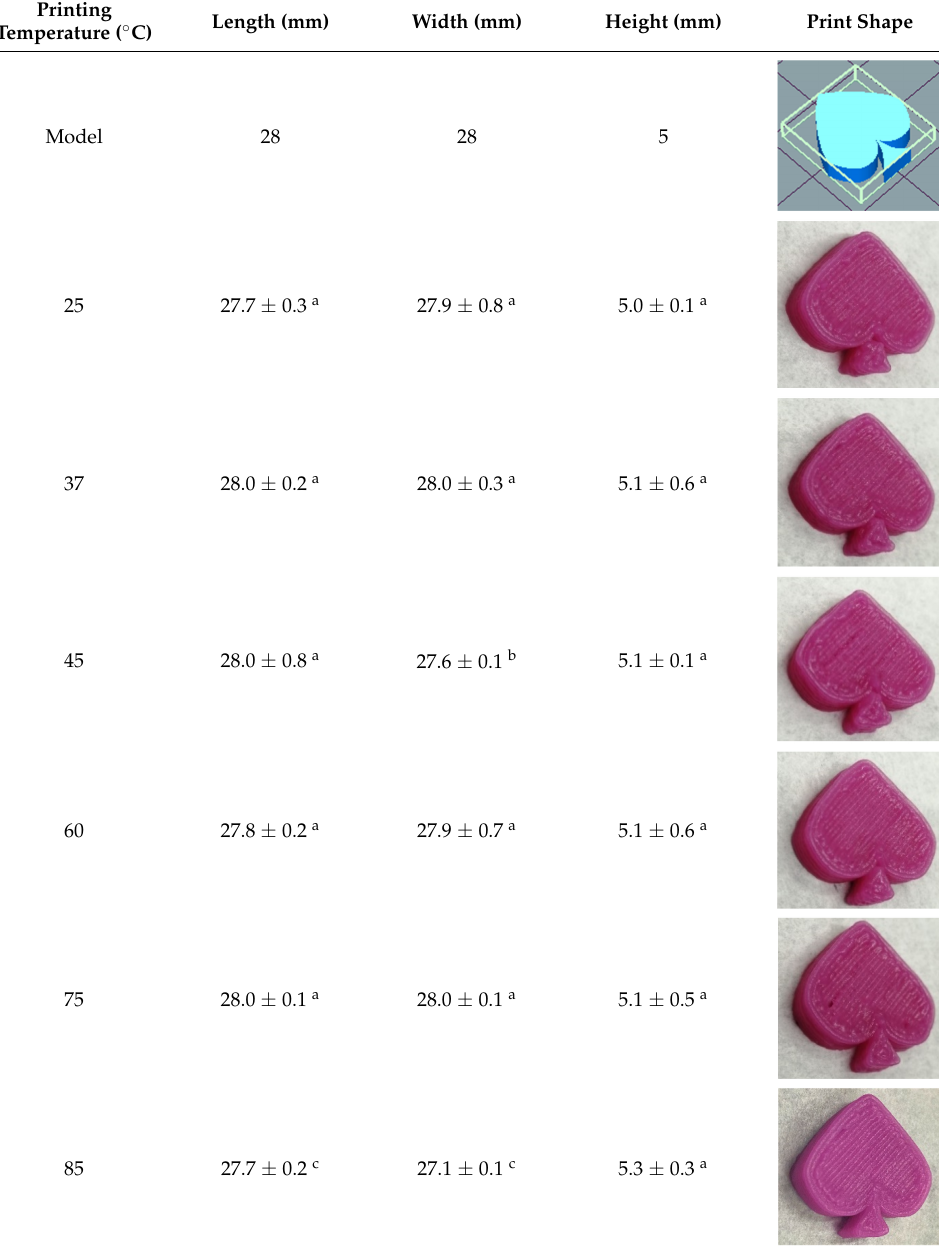
Table 4. Effect of temperature on 3D printing of AS